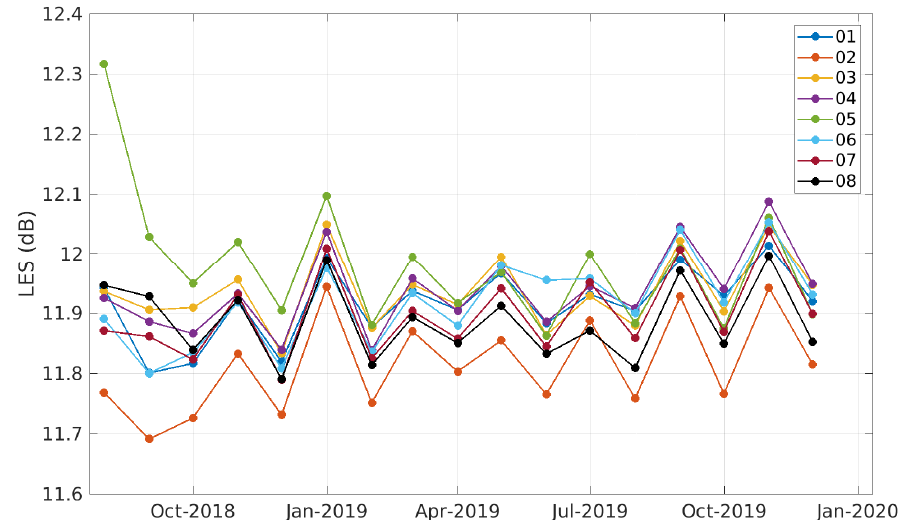
Figure A1. Temporal evolution of leading edge slope (LES) estimates at U10 ~7m/s, for all SVNs, segmented by CyGNSS Flight Model (FM01-FM08).